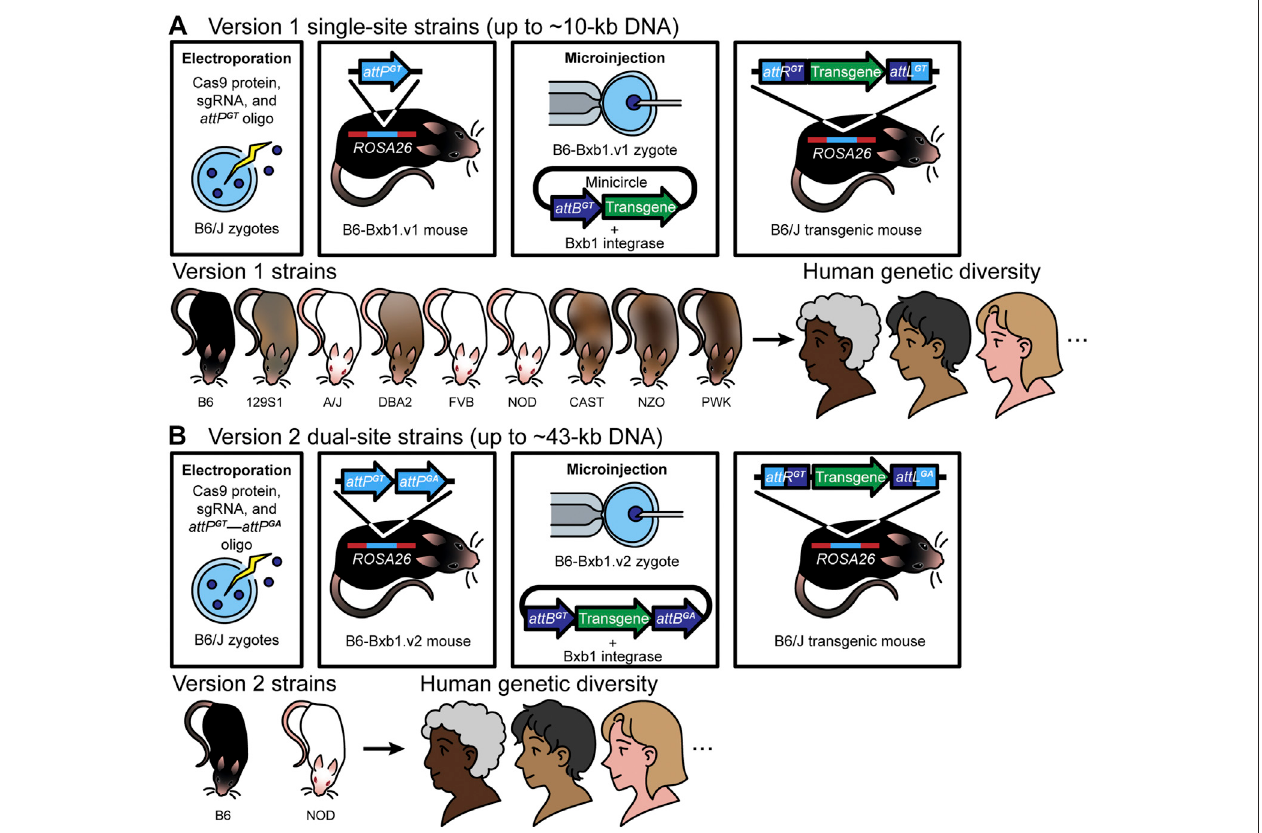
FIGURE1| Version1(RMKI): (A) Overthepast5 years,wehavegeneratedmiceusingversion1[the fi rst-generationCas9-Bxb1.v1toolbox(asingle attP GT siteandasingle attB GT site)] with successful targeted transgenesis of a series of DNA constructs up to 9.9 kb in length. The approach involves a) introduction of a single attP GT site into the safe harbor ROSA 26 locus using electroporation in mouse zygotes by CRISPR/Cas9-mediated HDR (A) , and veri fi cation of insertion by PCR and Sanger sequencing, b) from those zygotes, establishment of a sequence-con fi rmed attP GT mouse strain — B6-Bxb1.v1 mice, c) pronuclear microinjection of Bxb1 mRNA plus a large DNA construct (up to 9.9 kb) containing a single cognate attB GT site and the desired transgene into zygotes from matings of B6-Bxb1.v1 mice, for Bxb1 integrase-mediated insertion of DNA into the pre-placed attP GT siteforcreationoftransgenicmice,andd)con fi rmationofthecorrectDNAinsertion — recombinantattachmentleft( attL )andright( attR )sites — byPCR,Sanger sequencing,andNanoporelong-readsequencing,andsubsequentappropriateexpressionofthetransgene(toppanel).Notably,becausethegeneticbackgroundofmiceplays